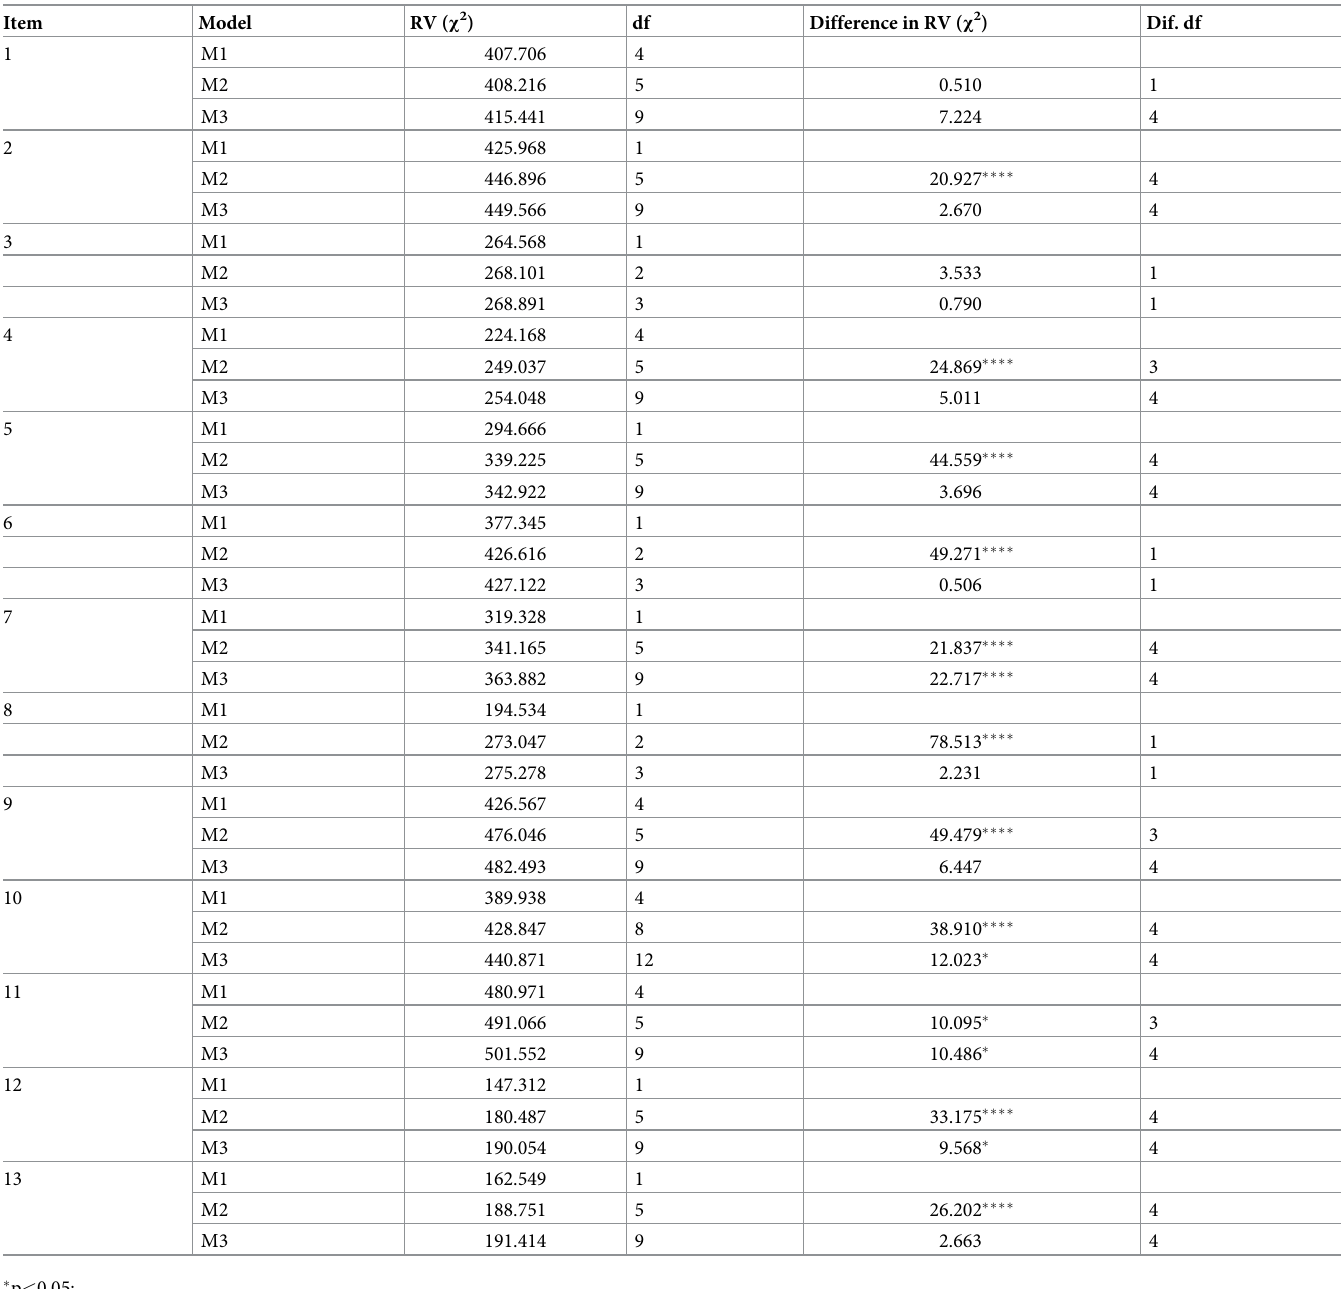
Table 2. DIF analysis by ordinal logistic